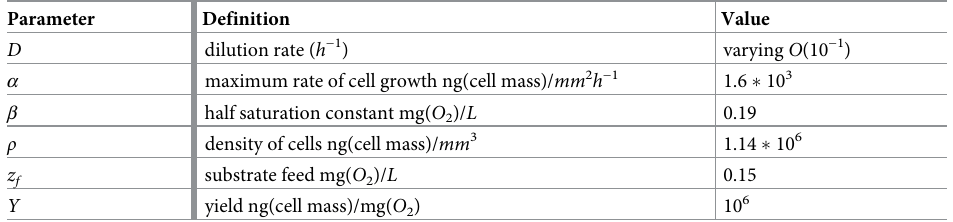
Table 1. Parameters and their order of